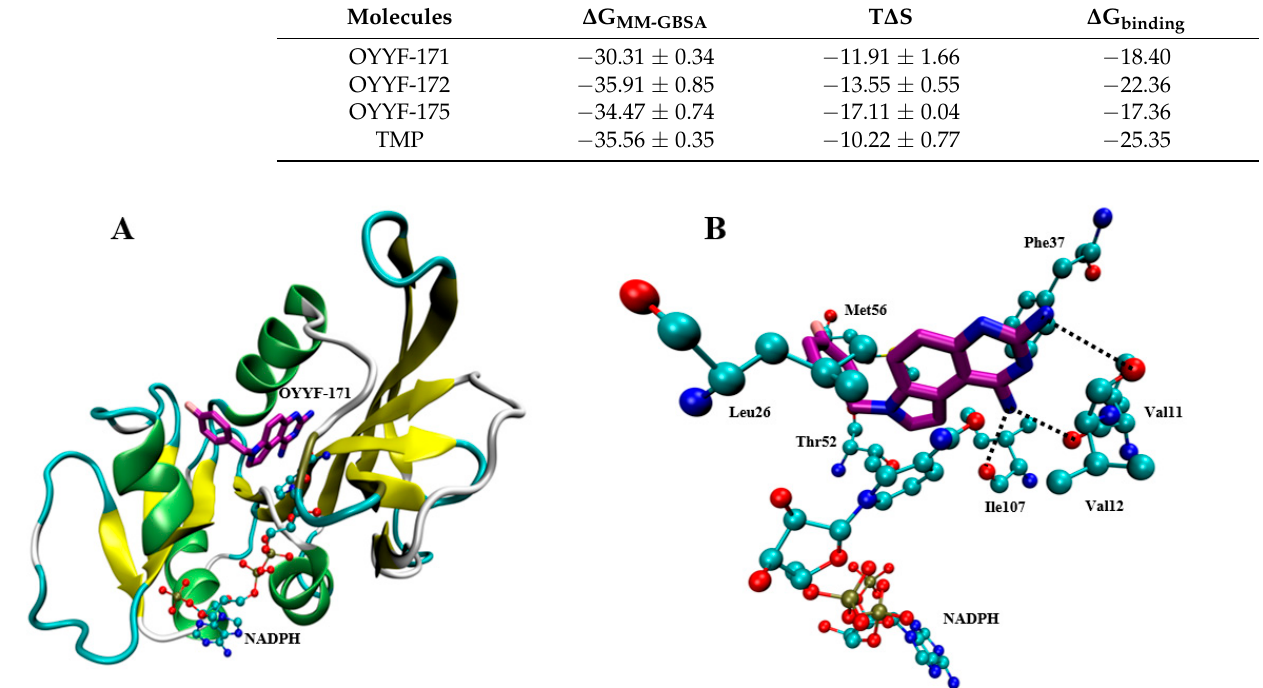
Figure 3. The binding poses of OYYF-171 with ab DHFR. In the current figure, the key residues were represented in a ball-and-stick model, in which oxygen atoms were colored red, nitrogen atoms were colored blue, sulfur atoms were colored yellow, and carbon atoms were colored cyan (in protein) or purple (in OYYF-171); the hydrogen bonds were represented by dotted lines. ( A ) The overview of the binding of OYYF-171-NADPH-DHFR. ( B ) The detailed interactions of OYYF-171 with the key residues of homology modeling on ec DHFR.